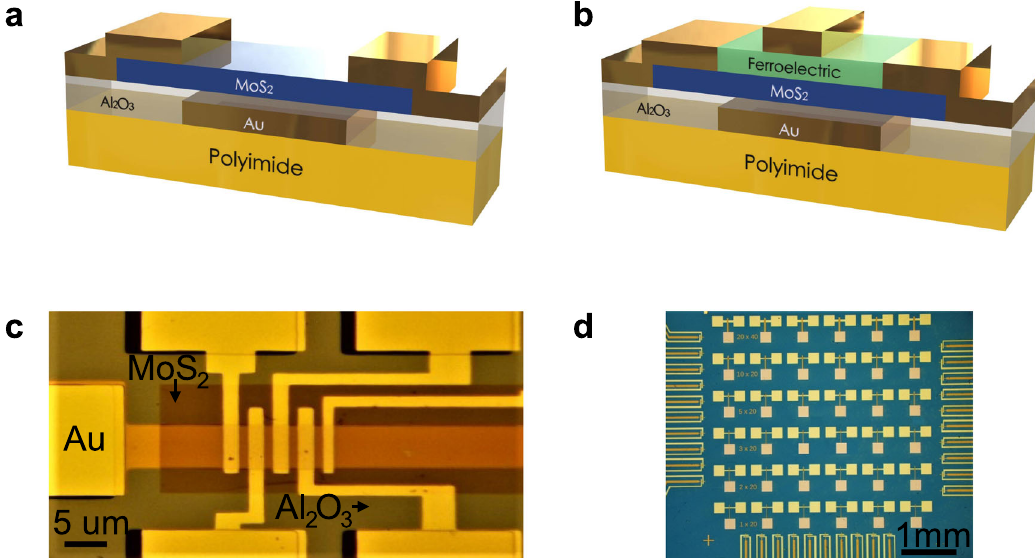
Fig. 6 Flexible device schematics and pictures. a FET schematic, b FeFET schematic, c transmission line measurement FET, d multiple bottom- gate FETs over 5 × 5 mm 2 area of polyimide